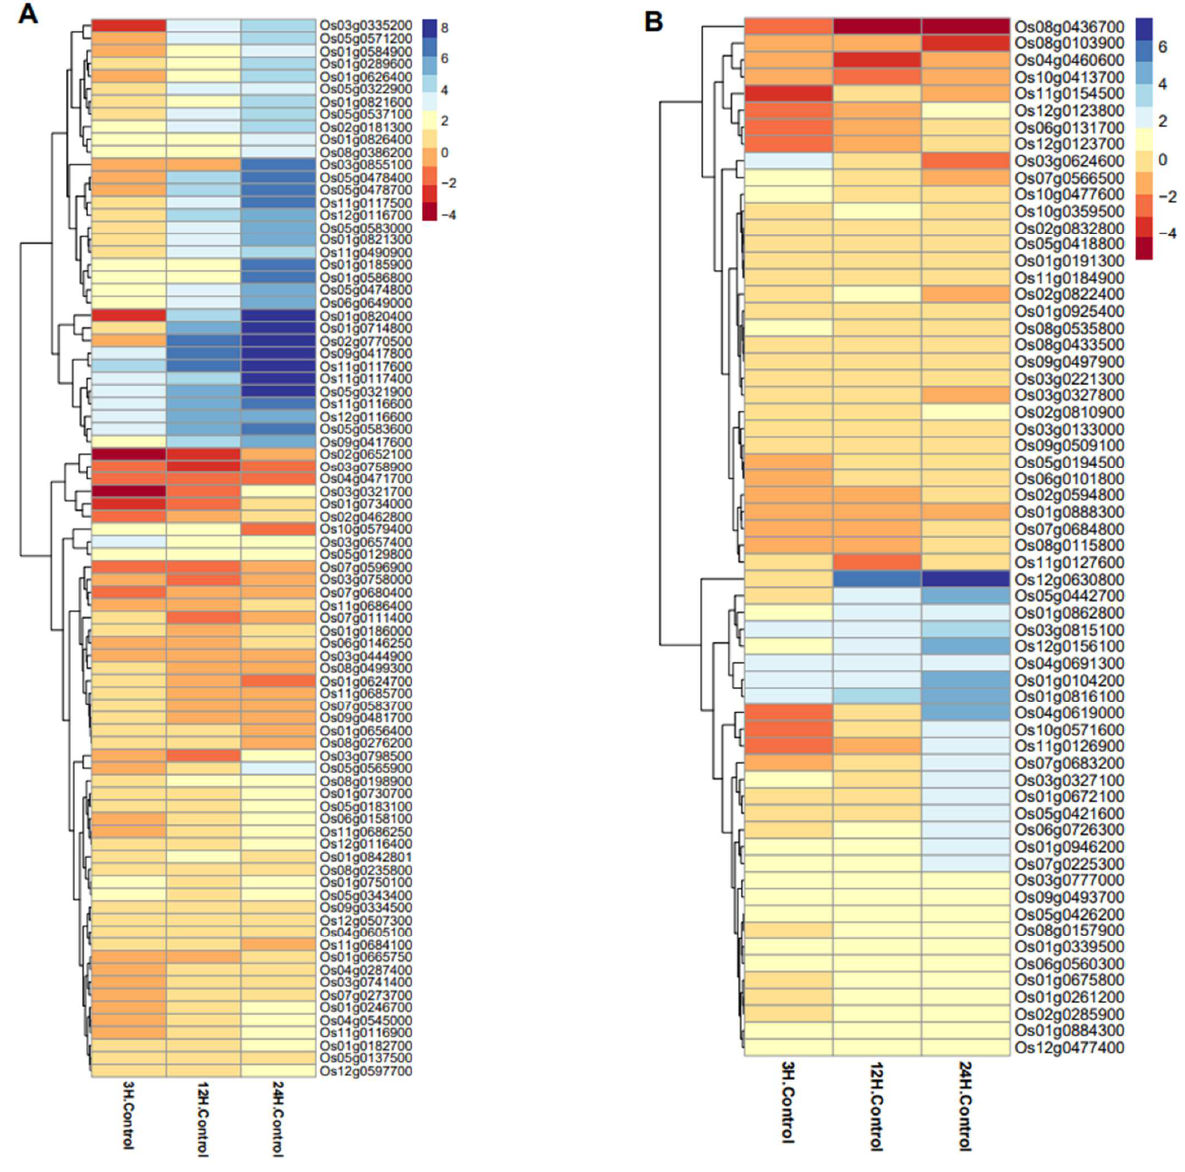
Figure 8. ( A ) Expression profiles of OsWRKYs in response to WBPH infestation at three different time points. Changes in gene expressions are shown in different colors. ( B ) Expression profiles of OsNACs in response to WBPH infestation at three different time points. Changes in gene expressions are shown in different colors.